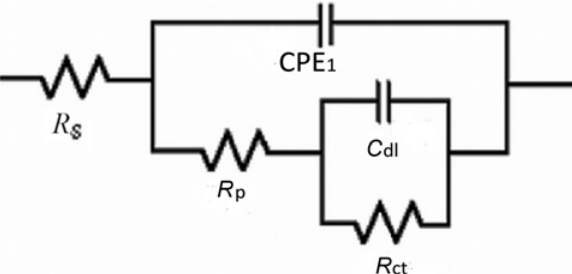
Figure 8: Equivalent circuit proposed to represent the corrosion mechanism of 316L samples compacted at three different pressures (200, 400 and 600 MPa) and sintered at 1,400°C.